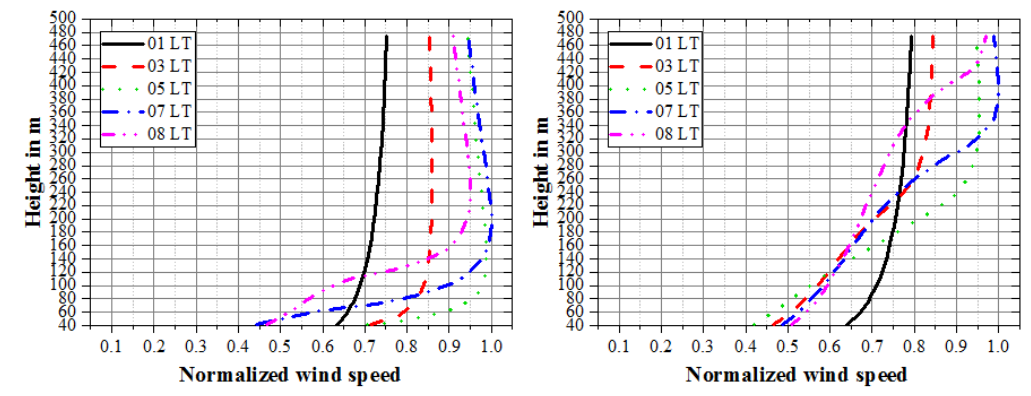
Figure 6. Vertical profiles of wind speed, left: v g = 4ms − 1 , right: v g = 10ms − 1 . Wind speed was normalized by maximum value at the LLJ core (left: 5.2ms − 1 , right: 12.0ms − 1 ) simulated by HIRVAC2D during a night (LT: local time, CET) in June (DOY = 170) over grassland, parameter values see Table 1 (PAI = 1, vegetation coverage =